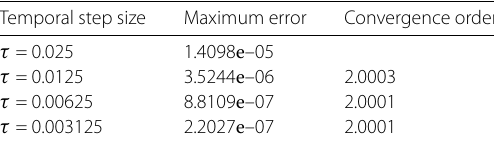
Table 5 The convergence order for R-CFDS4 at h = 0.0025